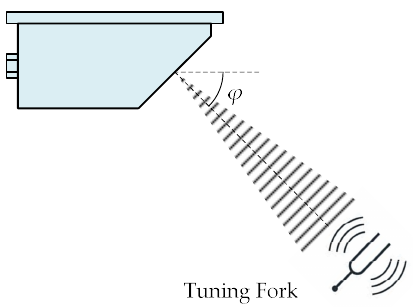
Figure 6. Schematic diagram of the traditional speed calibration method for a train-borne single-channel DRS by using tuning forks.